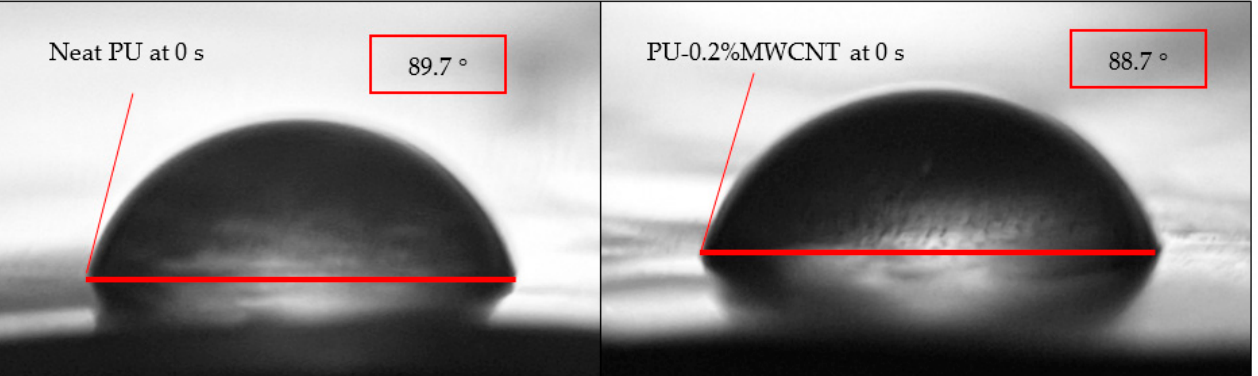
Figure 9. Water contact angle of PU and nanocomposite films from 0 s to 270 s.